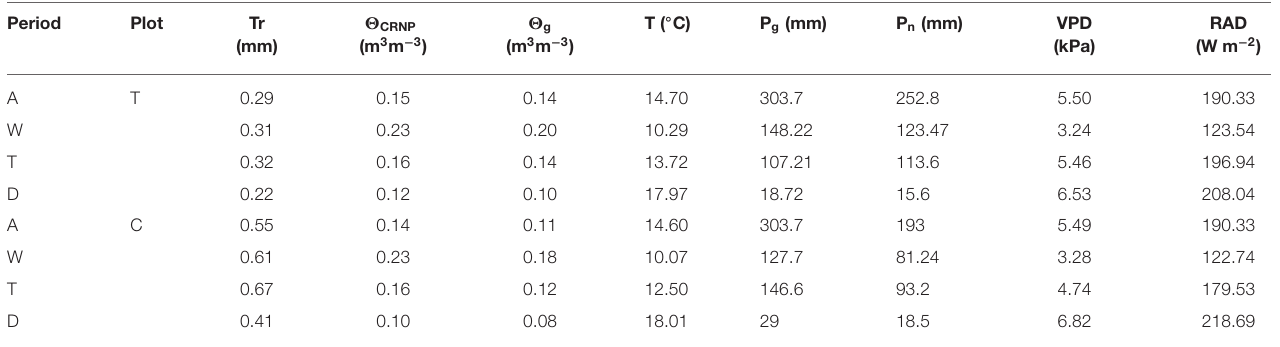
TABLE 3 | Summary of environmental variables for the complete time series period (A) and when considering the three sub-periods according to the kNN classification (W, wet period; T, transition period; D, dry period).